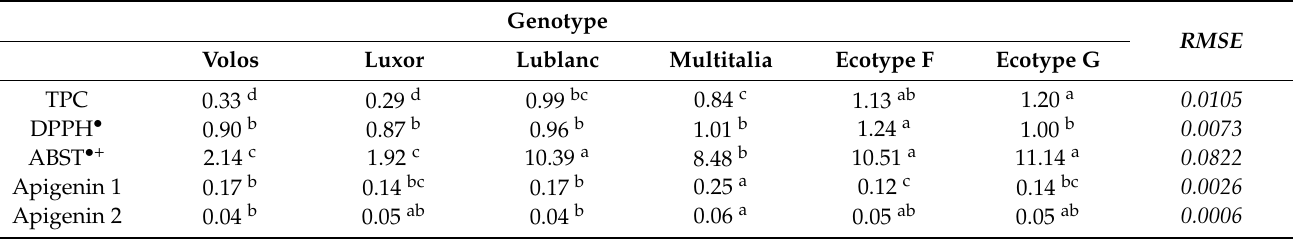
Table 5. Total phenolic content, antioxidant properties, and phenolic compounds in the six genotypes of Lupinus albus L. (n =